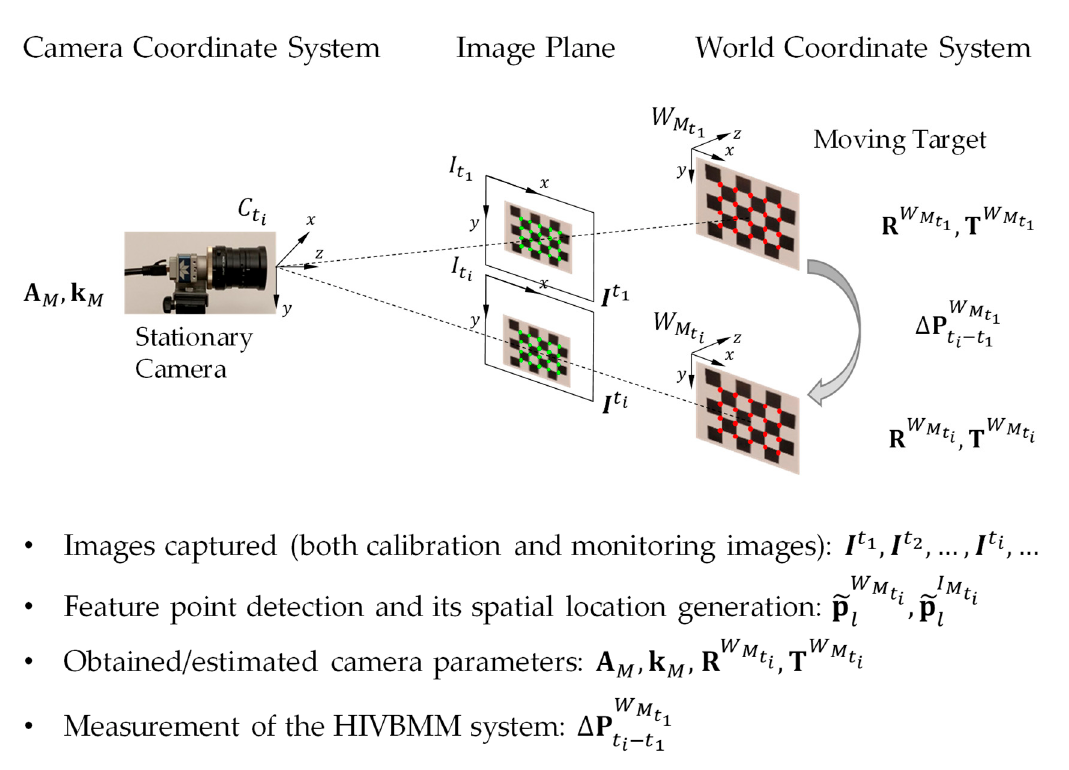
Figure 2. Illustration of structural displacement measurements using a stationary camera. The moving calibration target is assumed to have the same movements with the structure that is being monitored. The calibration images (need to cover the whole camera FOV) are taken before the monitoring images. For better visualization, only the monitoring images I t 1 , I t i are